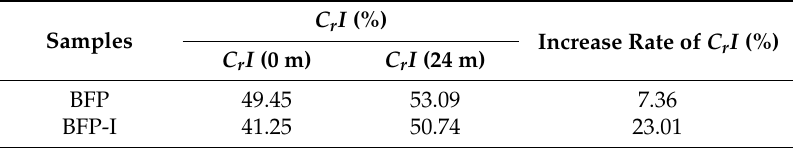
Table 3. Crystallinity index of different BFPs prepared by using different resins and at degradation